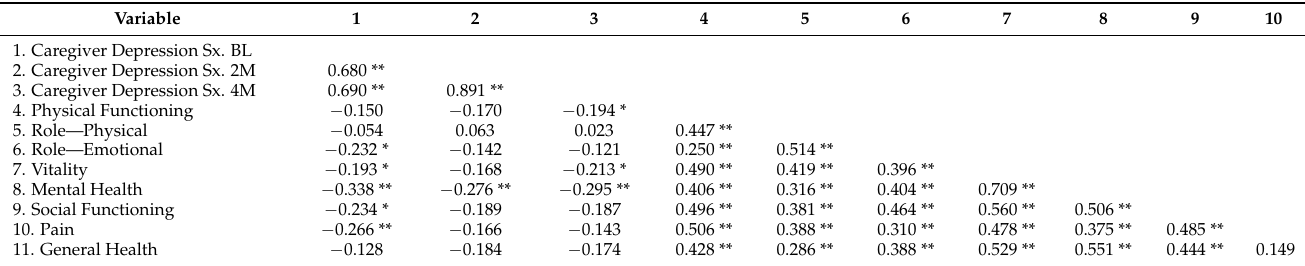
Table 2. Correlation